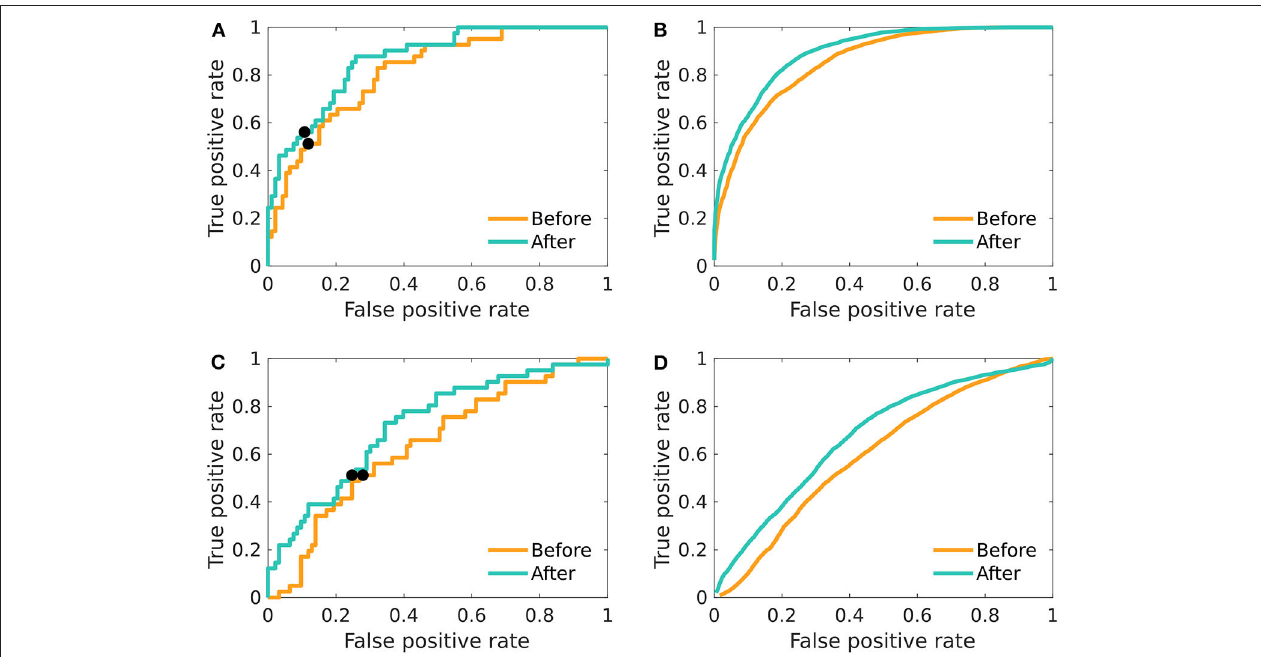
FIGURE 3 | The ROC curves of multivariate logistic regression. Differences between men and women in relative beta power across electrodes; before as well as after the treatment. (A) The model was fitted on the whole dataset using the relative beta power across all 19 electrodes. (B) The model was fitted 100-times on a balanced random subset of 80 patients, and the resulting ROC-curves were averaged. (C) The model was fitted and evaluated using leave-one-out validation scheme. (D) The average of ROC created by using random sex-balanced subsets of the data and using leave-one-out scheme in fitting and evaluating the logistic regression. The black pointers in (A,C) indicate the position on the ROC curve, for which the overall accuracy is reported in the Table 1